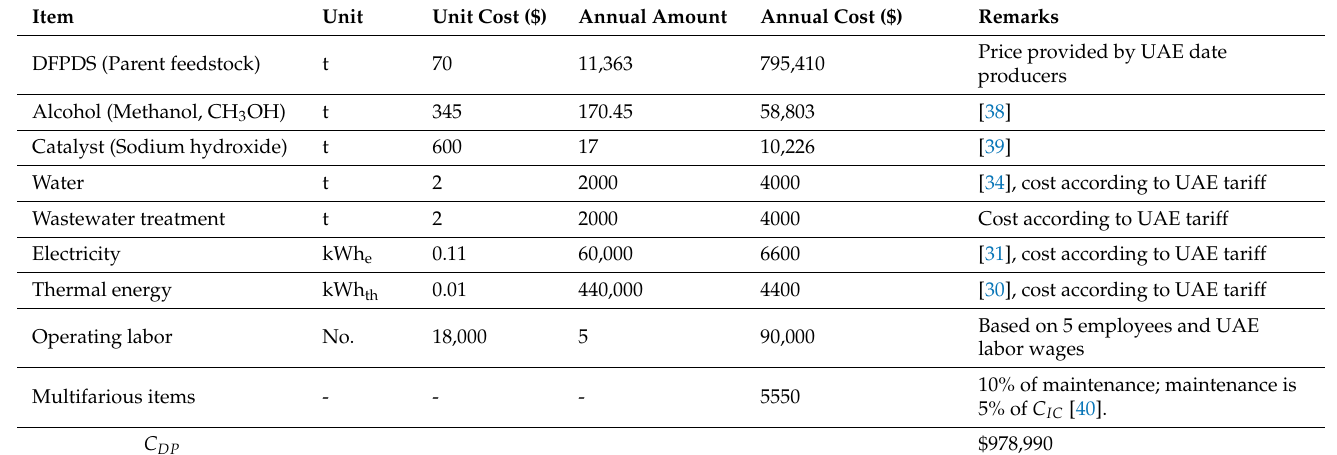
Table 4. Direct production cost ( C DP ) of a 1000 t/y DSO biodiesel production plant.